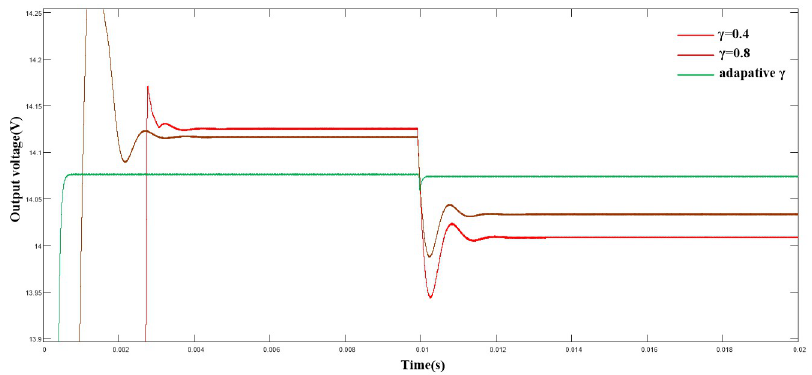
Fig 11. Comparison of output voltage with adaptive algorithm under load disturbance.